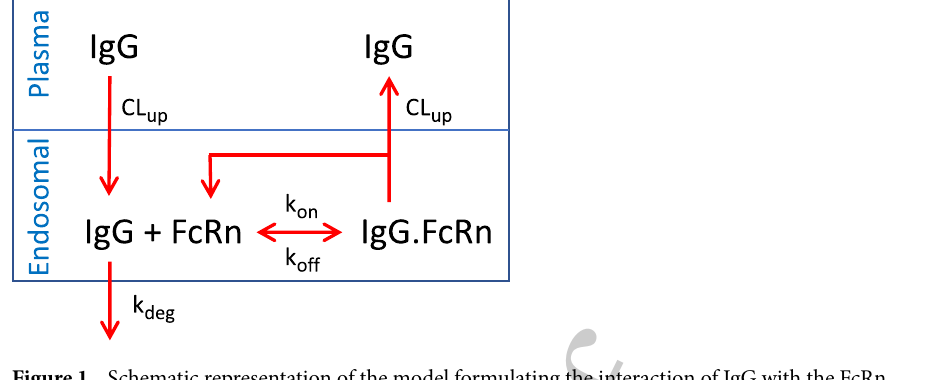
IgG . FcRn IgG IgG . FcRn 4 = k − k . C FcRn 1 C e ; e , R e on C off C e